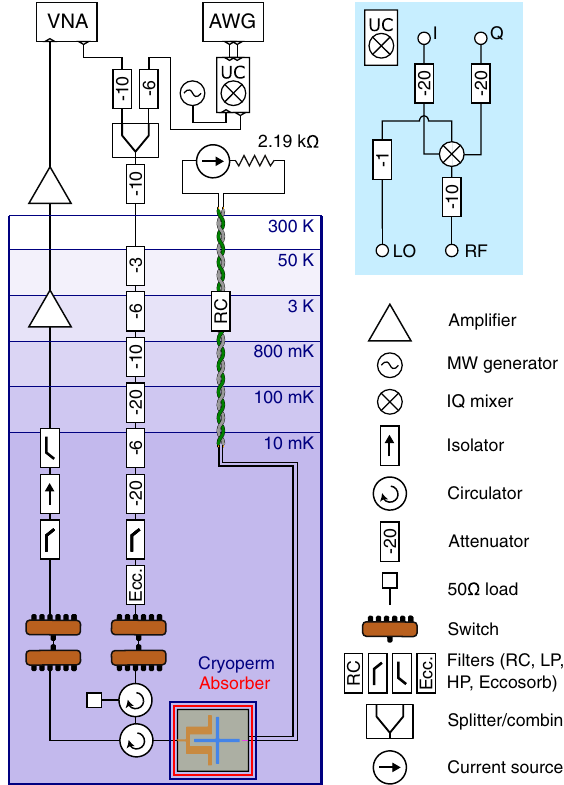
FIG. 6. Full wiring diagram for the experiment. MW is for microwave, LP for low pass, and HP for high pass.